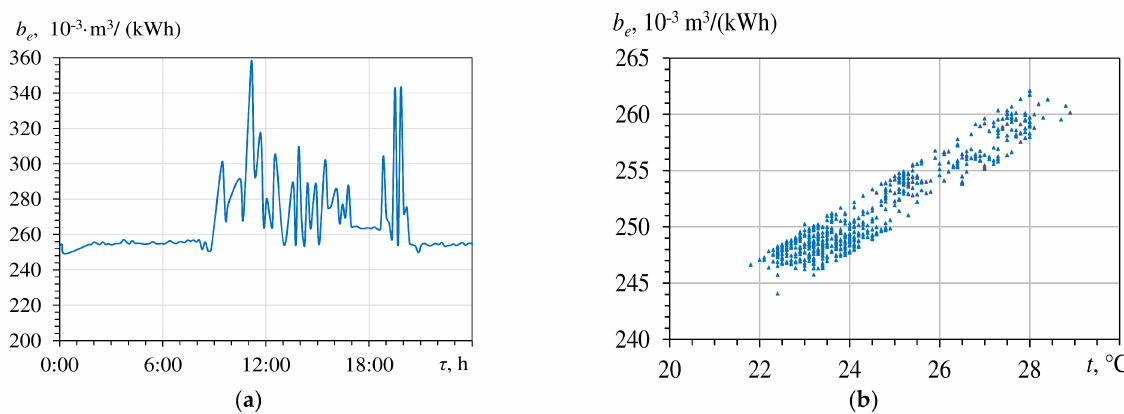
Figure 5. Daily variation of volume gas consumption B e ( a ) and electric power P e ( b ) of the gas engine against time τ .